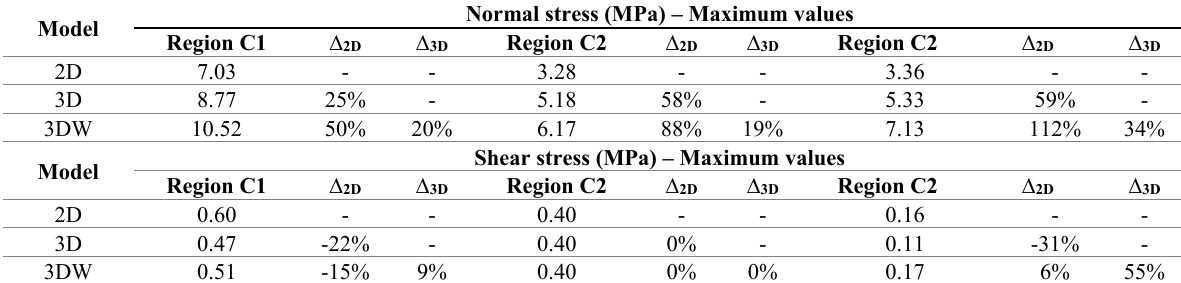
Table 3. Normal and shear stresses at the bottom of Wall